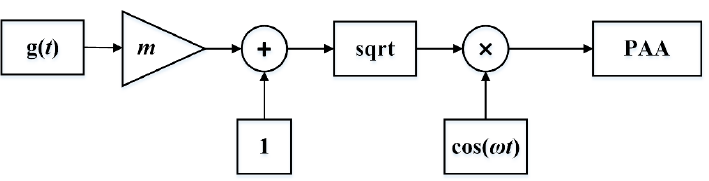
Figure 6. Block diagram of SQRAM.